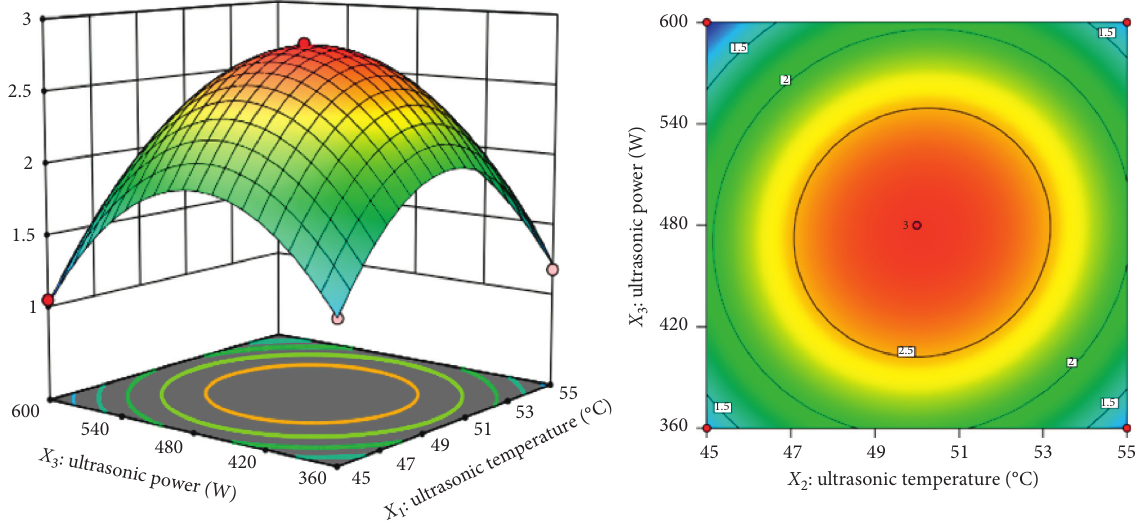
Figure 10: Simultaneous effect of ultrasonic temperature and ultrasonic power.